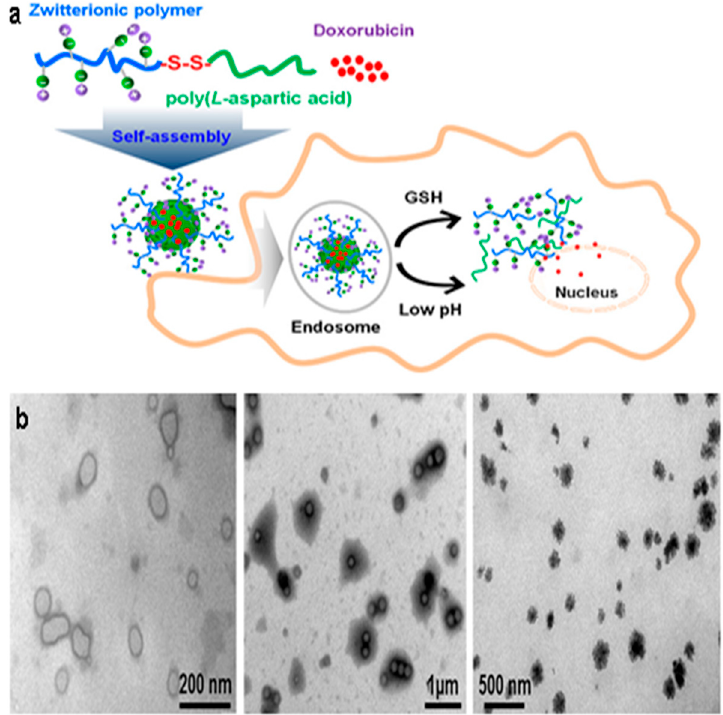
Figure 10. Schematic representation of the glutathione and endosomal pH-responsive release of drug from the poly(aspartic acid)-based hybrid vesicle ( a ) and TEM images of micelle at pH 7.4, 5.5 and at 5.5 in the presence of DTT ( b ). Reproduced with permission from [170]. Copyright 2017, Elsevier.